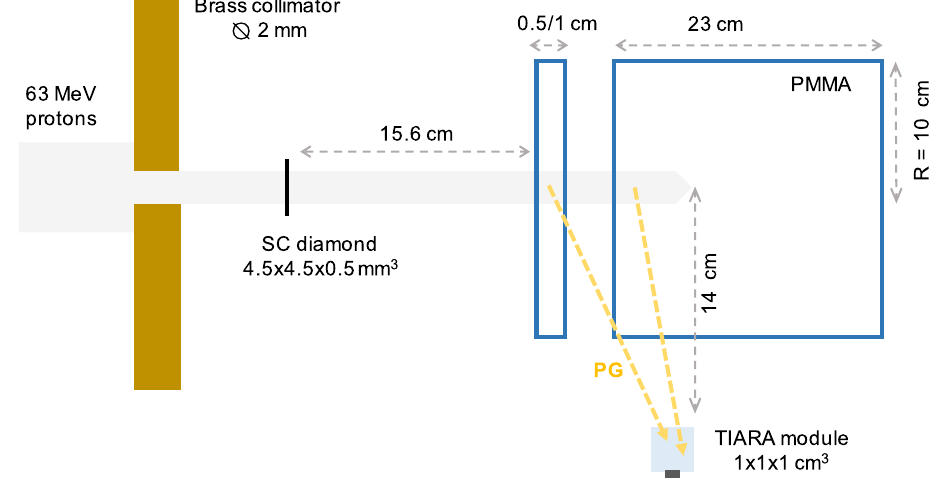
Figure 1. Set-up of the experiment carried out at the MEDICYC facility with 63 MeV protons. A first version of the TIARA module, composed of a 1 cm 3 PbF 2 crystal coupled to a 3 region at 90 ◦ , was tested in time coincidence with a sc diamond detector of 4.5 the time and energy response characterisation, only PG signals from the thin PMMA target (cylinder of 10 cm radius) were considered: repeated measurement were carried out with either a 5 mm or a 1 cm thick target and the results were then averaged. The second target (cylinder of 10 cm radius and 23 cm thickness) was employed in the measurement of the proton range sensitivity; initially placed at 3 cm distance from the thin target, it was progressively moved by 2, 4, 6 and 10 mm in order to induce an artificial shift in the proton range. All the targets have a density of 1.19 g/cm 3